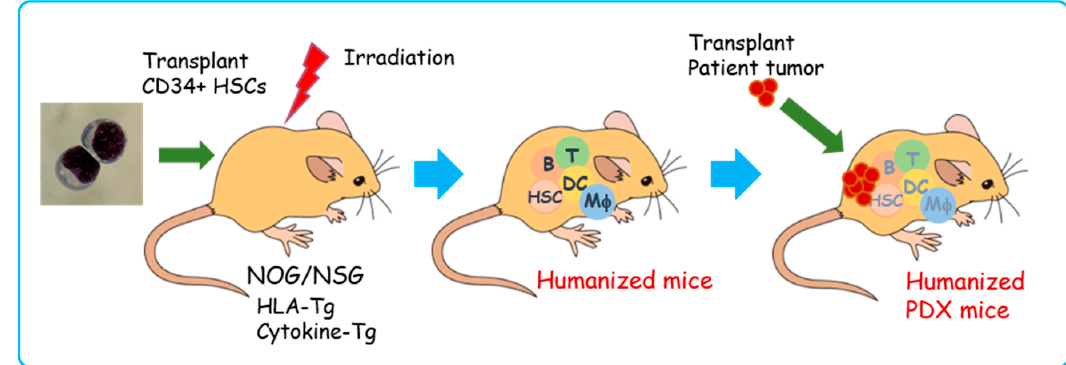
Figure 6. Schematic illustration of humanized PDX model generation. First, CD34+ human hematopoietic stem cells are transplanted into irradiated human leukocyte antigen (HLA)/human cytokine transgenic (Tg) NOG/NSG mice. Then, human hematopoietic and immune systems are reconstituted within 8–12 weeks (humanized mice). Patient ‐ derived tumors are transplanted into humanized mice (humanized PDX mice). T: T lymphocytes, B: B lymphocytes, DCs: dendritic cells, M φ : macrophages, HSCs: hematopoietic stem cells, HLA ‐ Tg: human leukocyte antigen class I and II transgenic mice, Cytokine ‐ Tg: human cytokine (stem cell factor (SCF), IL ‐ 3, granulocyte ‐ monocyte colony stimulating factor (GM ‐ CSF), thrombopoietin (TPO), etc.) transgenic mice.